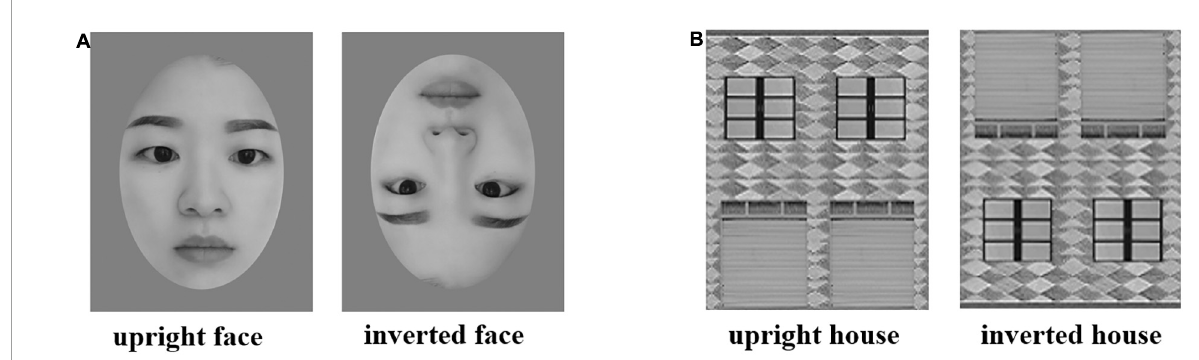
FIGURE2 The example of the upright-face conditions for one trial. Participants are required to judge whether the study face and the following test face are identical.